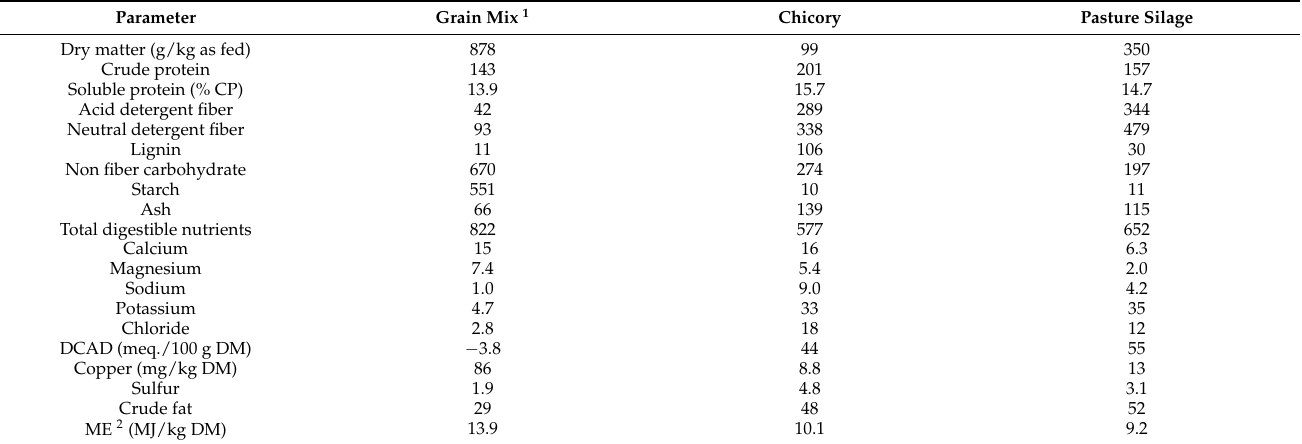
Table 1. Composition of main dietary ingredients (g/kg DM unless otherwise stated). Parameter Pasture